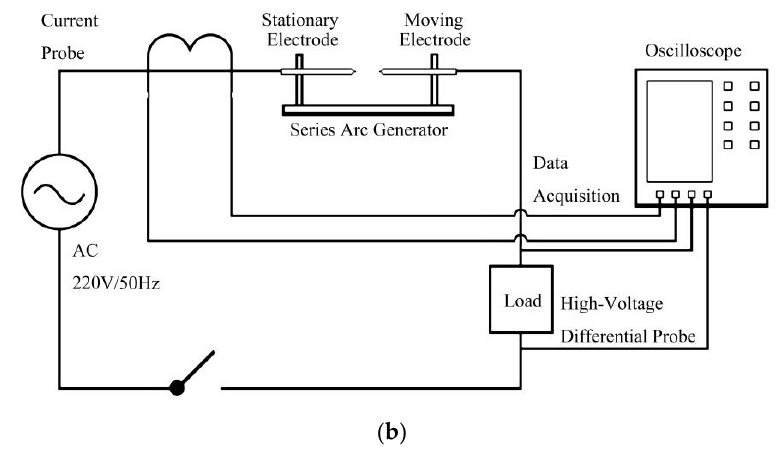
Figure 14. Series arc fault test. ( a ) Laboratory test platform. ( b ) Experimental circuit diagram.